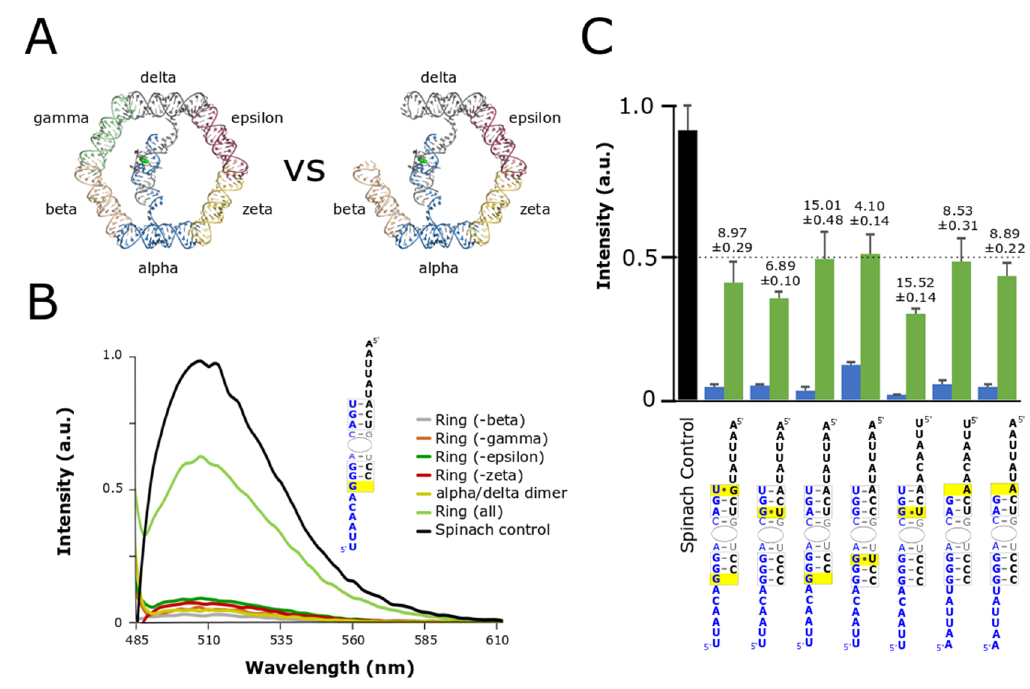
Figure 3. Comparison of fully- and partially-assembled nanorings. ( A ) In order to function as an effective tool for verifying and monitoring nanoring assembly the system needed to be able distinguish between whole and incomplete or partially-assembled nanorings. ( B ) Fluorescent data comparing fully-assembled to nanorings missing one of the four supporting struts (beta, gamma, epsilon, or zeta). ( C ) Summary of average fluorescent values for whole nanoring assemblies and partial assemblies compared to Spinach control where the green bar represents the complete nanoring and the blue bar represents the partially-assembled nanoring. The ratio of fluorescence of ring to partially-assembled (ring missing one strut) is shown above each plot. Data is based on a minimum of three trials. The error bars represent the standard deviation associated with each collection of measurements.